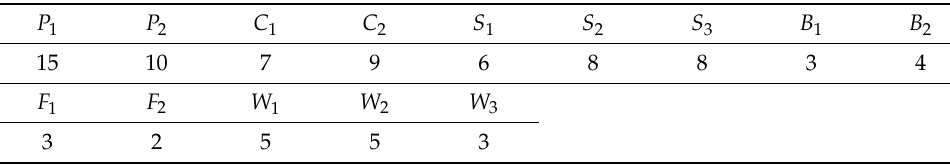
Table 3. Initial values of each